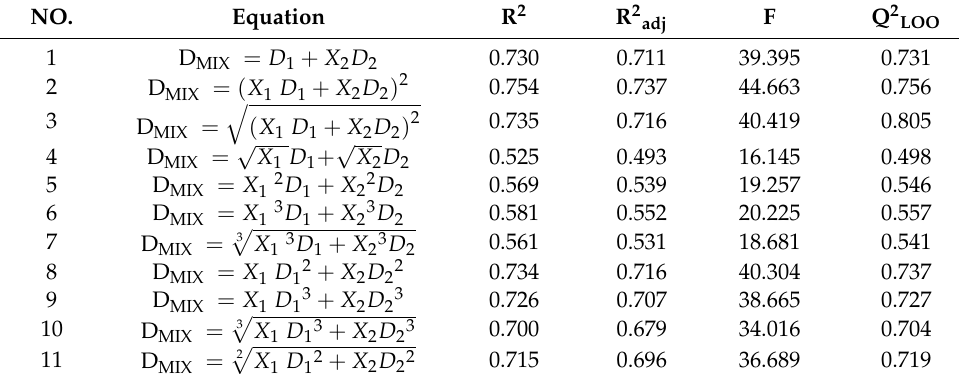
Table 1. The 11 different mixing rules and statistic parameters of the individual compound model.